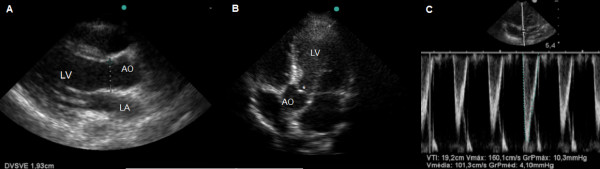
Cardiac index calculation. A- Measurement of the left ventricle outflow tract by the parasternal long-axis view (diameter of the aortic annulus during systole). B and C- Measurements of aortic VTI through pulsed wave sample volume (*) at the aortic annulus (apical 5-chamber view). Ao, aorta; LA, left atrium; LV, left ventricle.